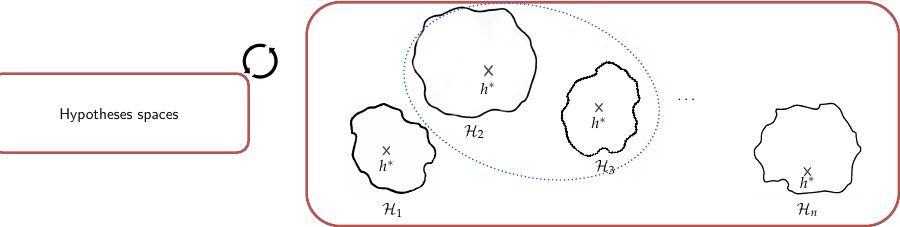
Figure 16. Surrogate model-informed selection of inductive biases where, among the hypothesis spaces family H , a set of concurrent hypothesis spaces (each of which containing a possibly suitable optimal hypothesis) is maintained throughout the learning process and model